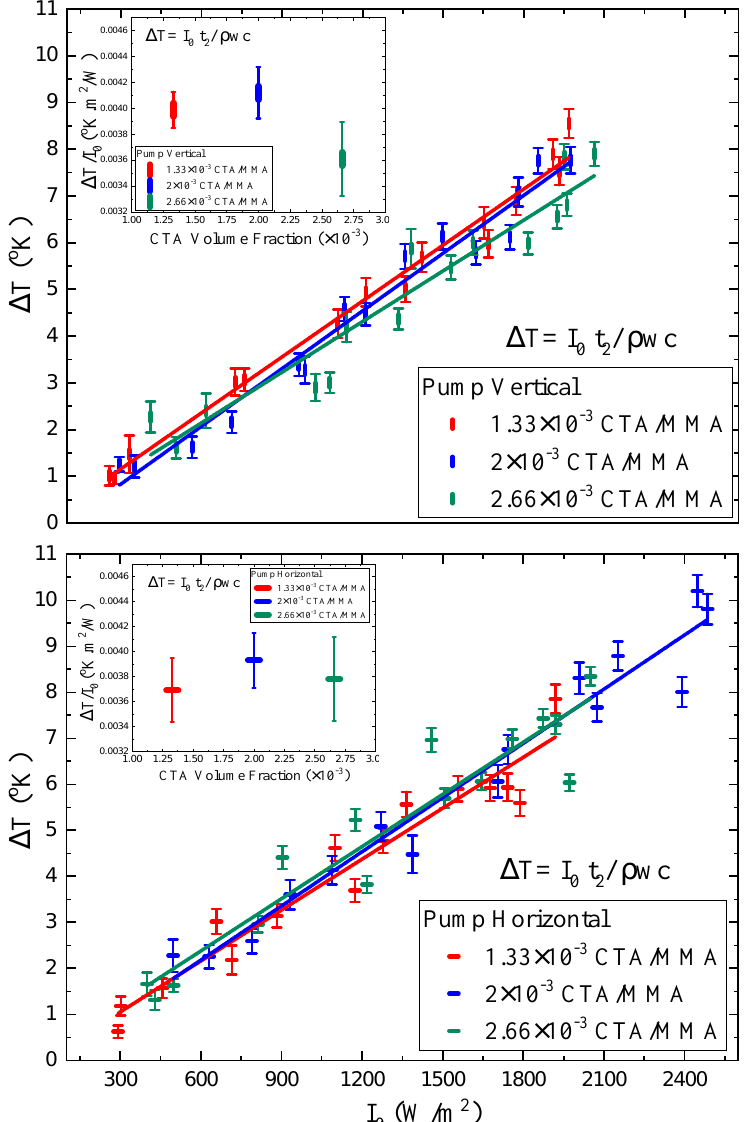
Figure 16. Temperature change as a function of intensity calculated from Equation (4) using the time constants measured from the photomechanical response, the density, heat capacity, and the sample’s dimensions. The insets show the temperature change per unit of absorbed intensity as a function of CTA volume fraction averaged over all intensities. The plots use t 2 to get ∆ T for vertically and horizontally polarized